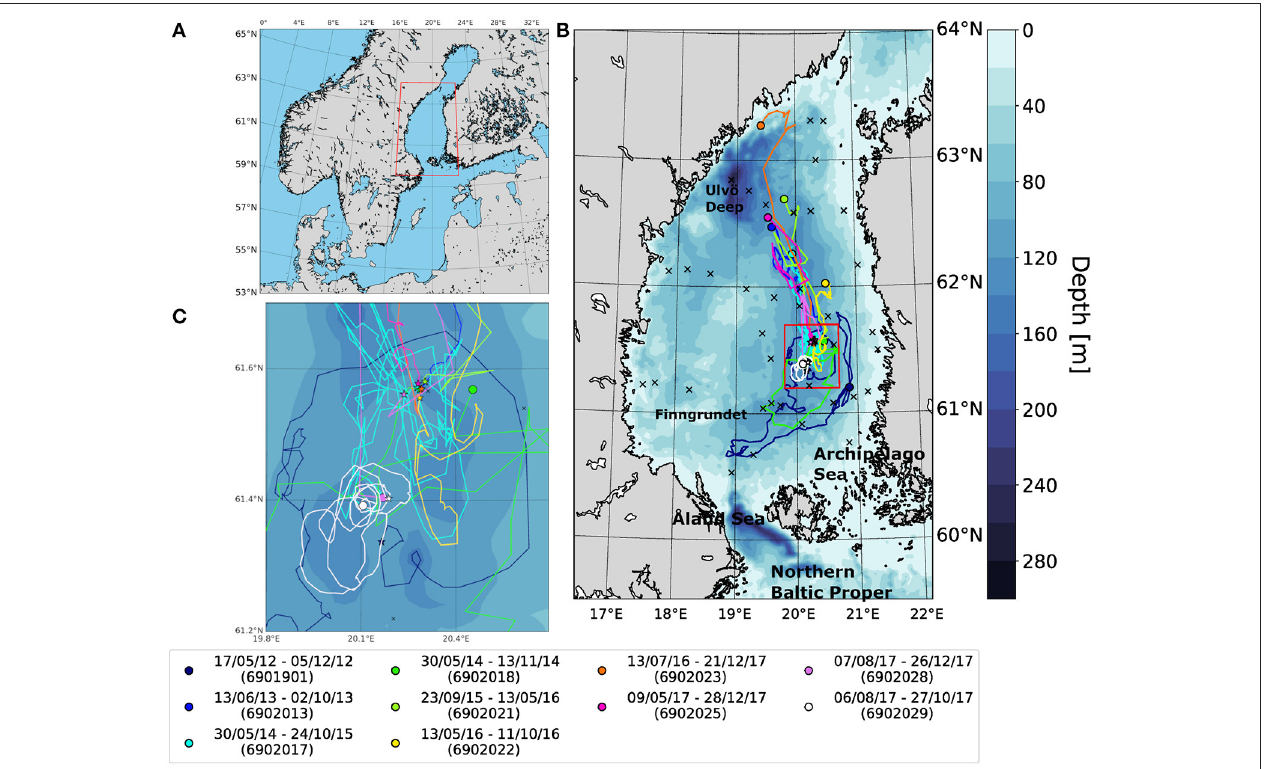
FIGURE 1 | (A) Bothnian Sea location in the Baltic Sea (B) , Argo float drift routes in the Bothnian Sea, and (C) a zoomed in map of the deployment area. The colors indicate separate deployments, and the stars and circles represent the deployment point ant the point of float retrieval or of latest profile, respectively. The black x:s show locations of CTD-profiles measured in the Bothnian Sea deep during 2012–2017. The bathymetry data is from Seifert et al. (2001).